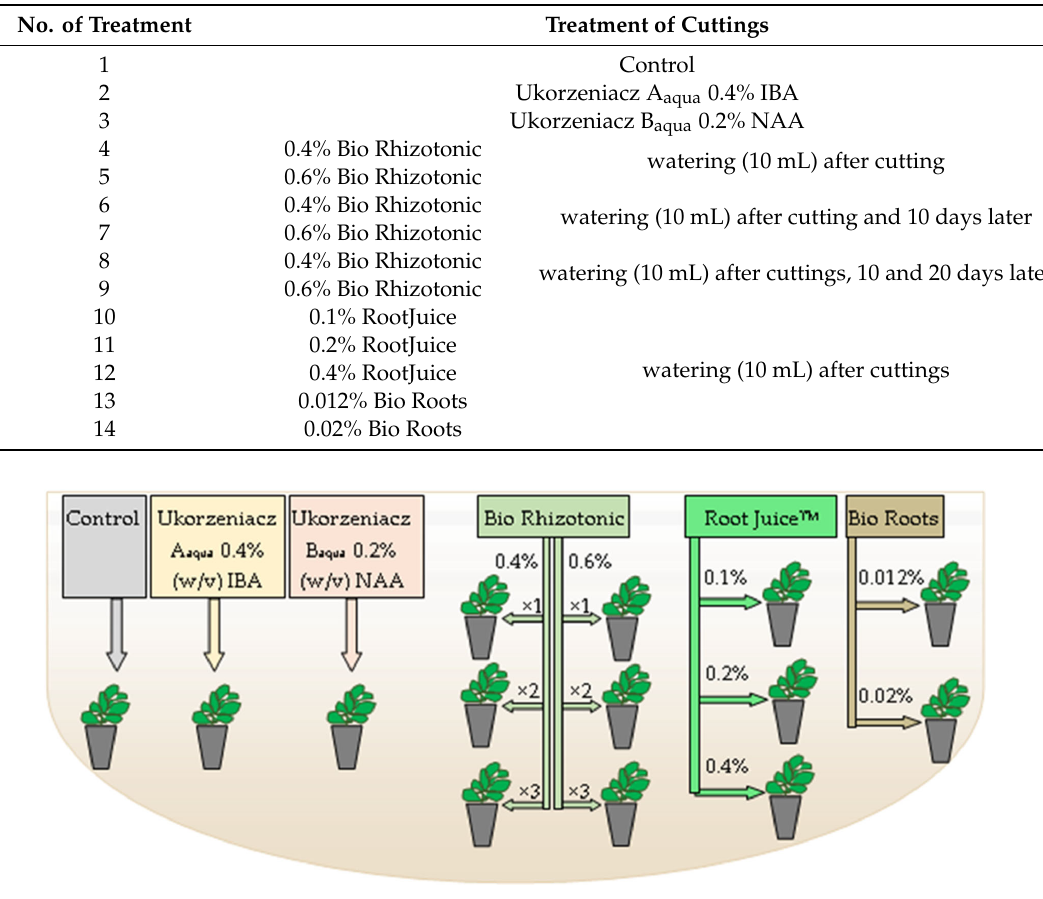
Table 2. The auxin and plant origin preparation treatments of cuttings of Rosa ‘Maiden’s Blush’ at each phenology stage in the research.